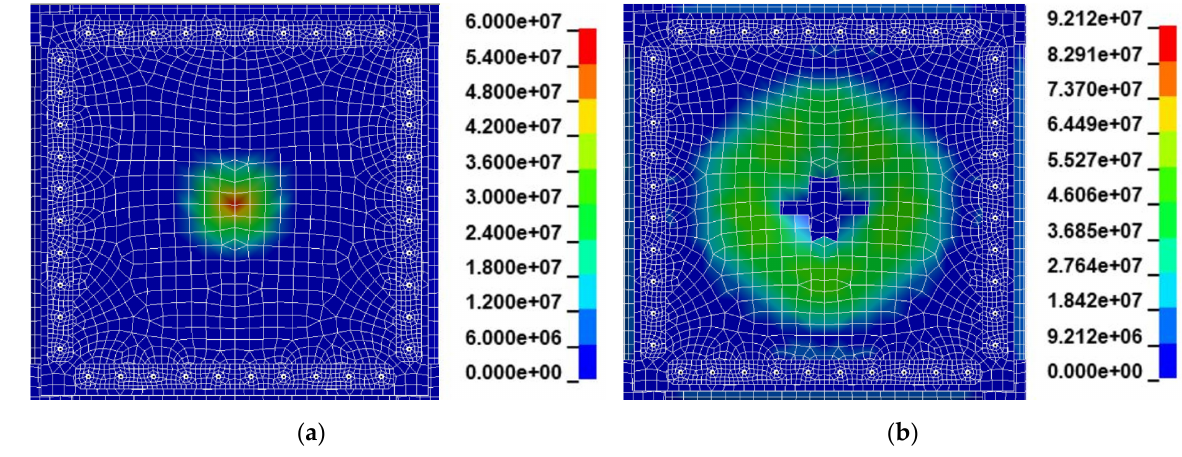
Figure 32. Distributions of Von Mises stresses before ( a ) and after ( b ) the puncture of the plate.